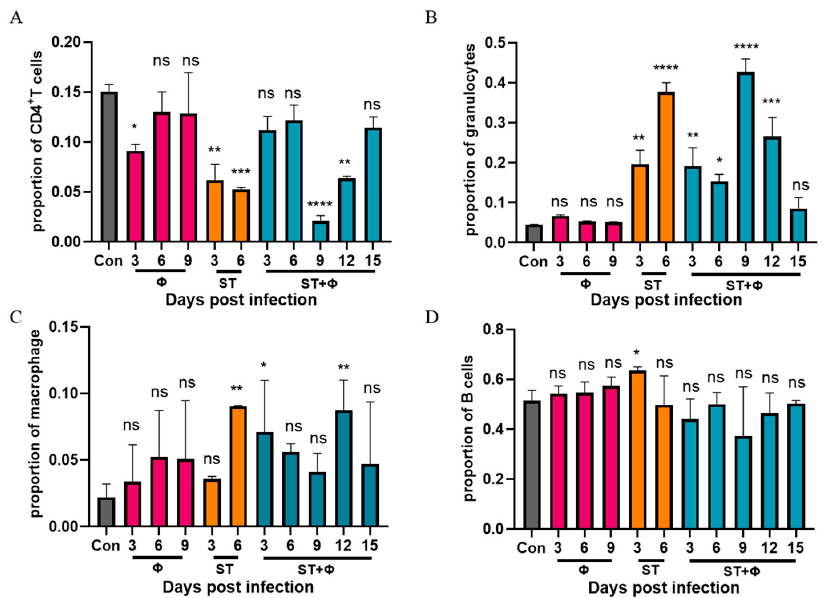
Figure 5. Phage therapy effect on immune responses in spleen in vivo. ( A ) Percentage of CD4 + T cells in live splenocytes. ( B ) Percentage of granulocytes in live splenocytes. ( C ) Percentage of mac- rophage in live splenocytes. ( D ) Percentage of B cells in live splenocytes. *, p < 0.05 (Kruskal–Wallis test), **, p < 0.01, ***, p < 0.001, ****, p < 0.0001; ns, no difference.